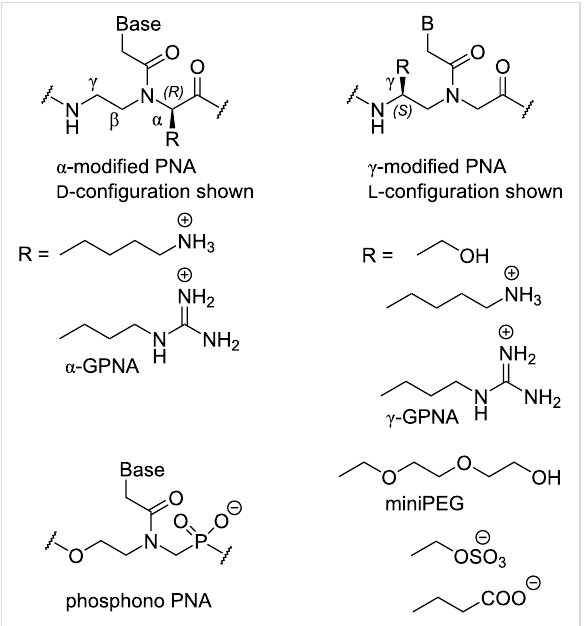
Figure 5: Structures of PNA having α - and γ -substituted backbones.